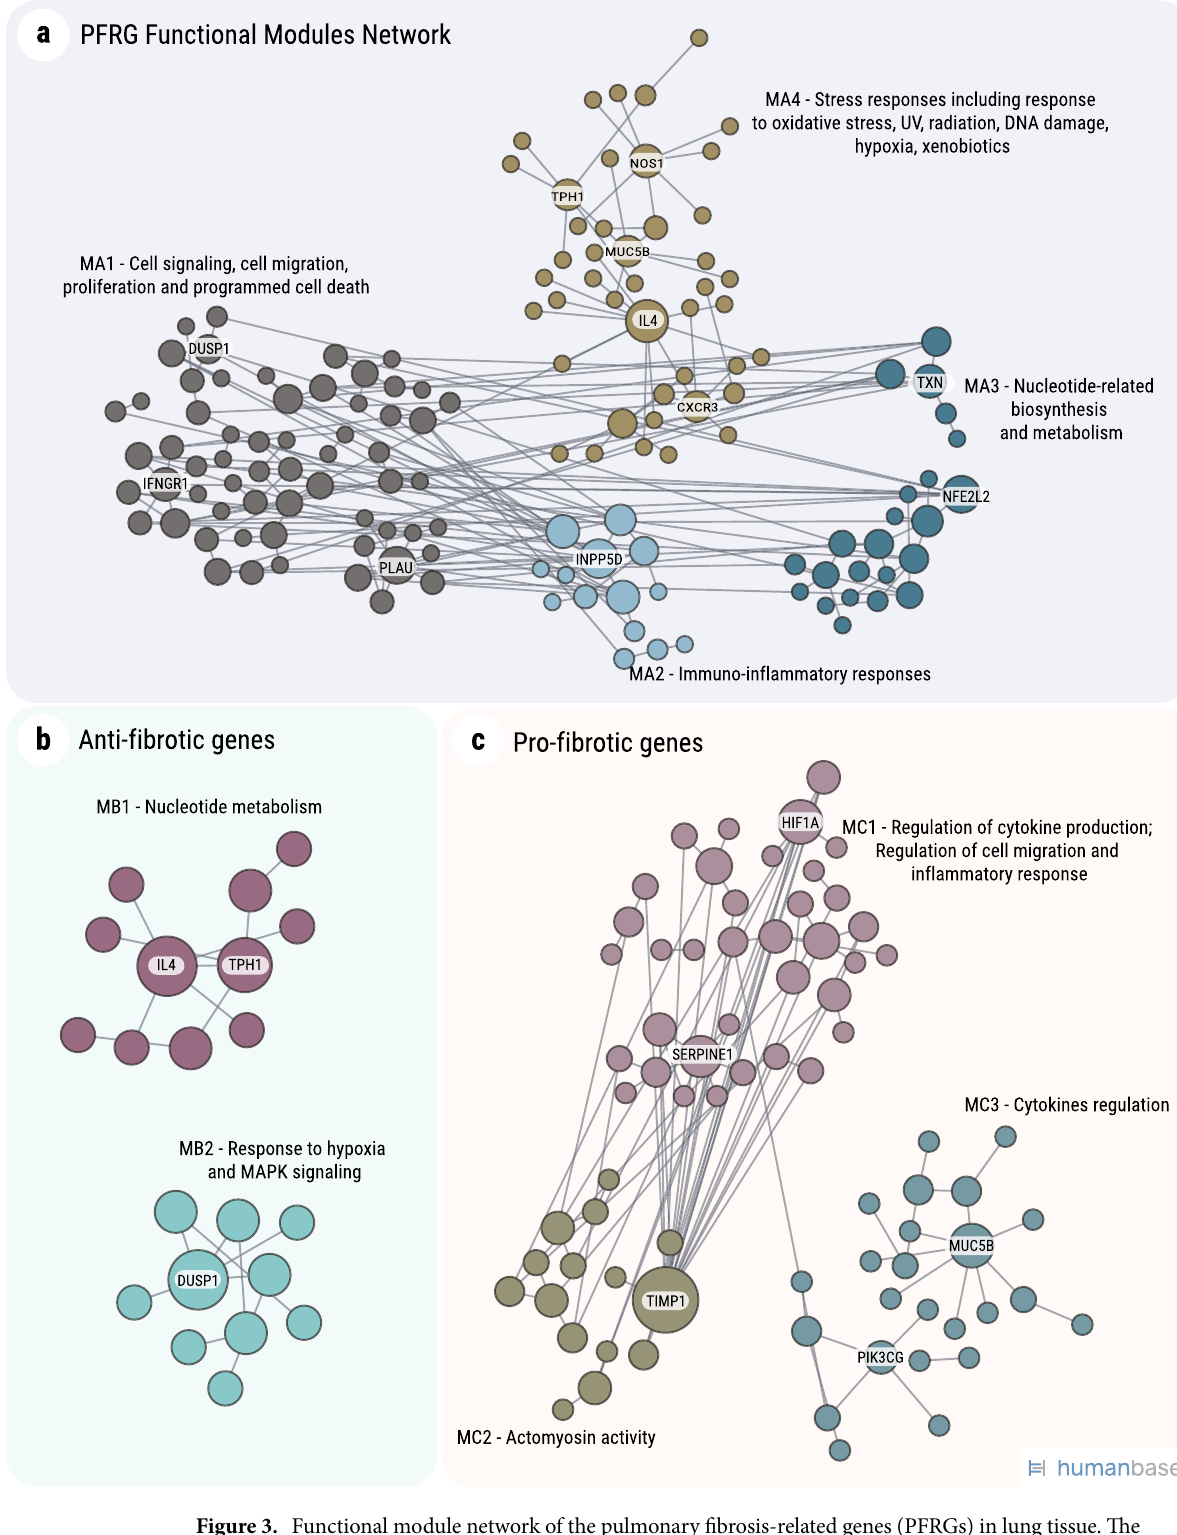
Figure 3. Functional module network of the pulmonary fibrosis-related genes (PFRGs) in lung tissue. The network was built for the lung tissue, using HumanBase, with the human orthologs of PFRGs as input. The interaction network is built using the closest gene neighbors and then clustered based on enrichment in GO categories. ( a ) All PFRGs. ( b ) Anti-fibrotic genes. ( c ) Pro-fibrotic genes. The networks were generated with HumanBase online tool (https:// hb. flati ronin stitu te.